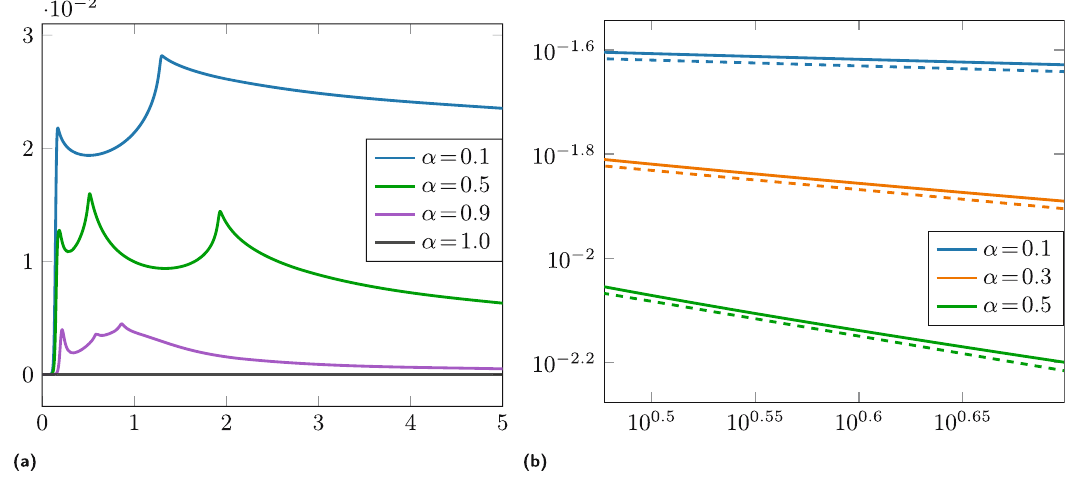
Figure 4: ( a ) The evolution of the history energy (cid:6) for { } ∈ α 0.1, 0.5, 0.9, 1.0 and [ ] ∈ t 0, 5 . ( b ) Asymptotic behavior of the history energy (cid:6) on the logarithmic scale. Dashed lines correspond to the slope of t β − with { } ∈ β 0.11, 0.36, 0.65 , from top to bottom, respectively. ( a ) History energy ( ( )) ↦ (cid:6) t u t ˜ . ( b ) Asymptotic behavior of the history energy (cid:6)